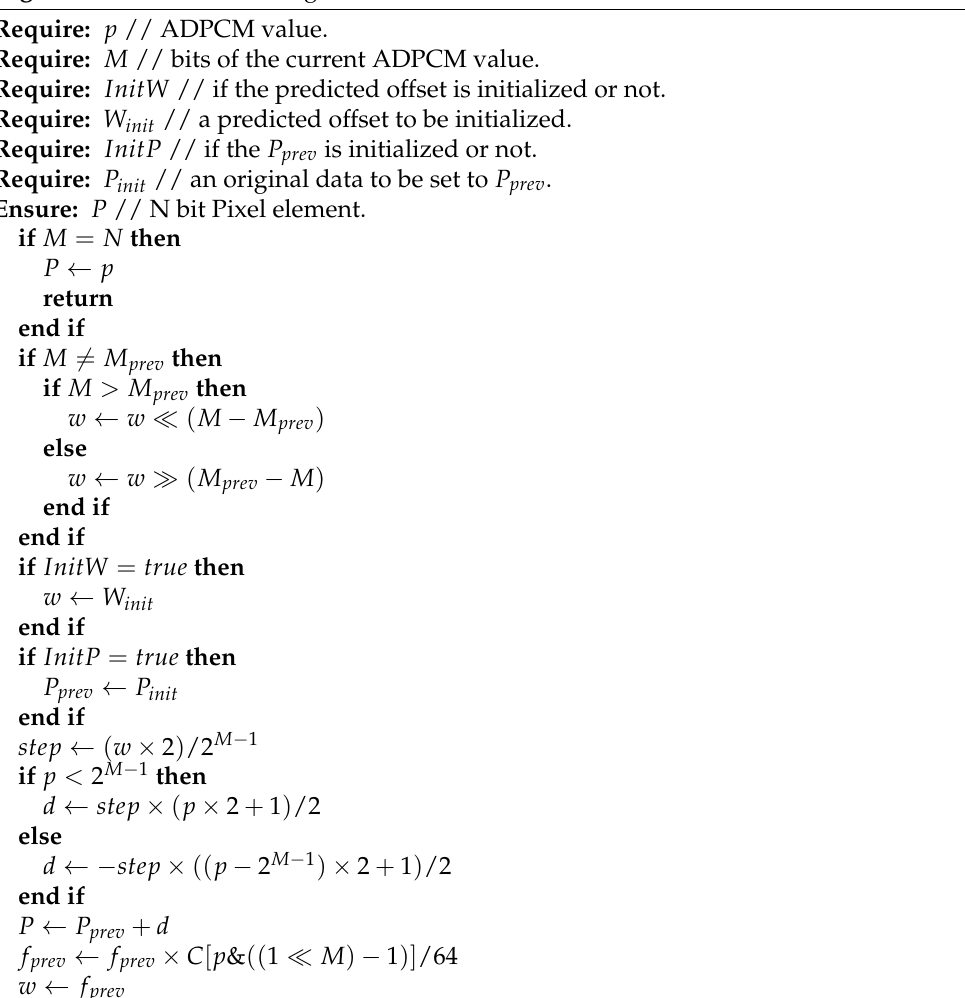
Algorithm 6 Variable bit-length ADPCM